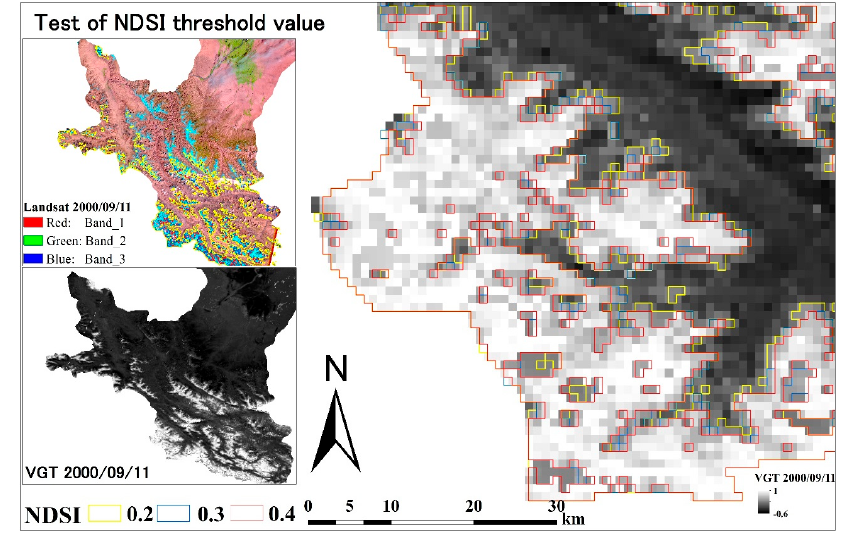
Figure 3. Test results of different threshold value for the Normalized Difference Snow Index (NDSI).